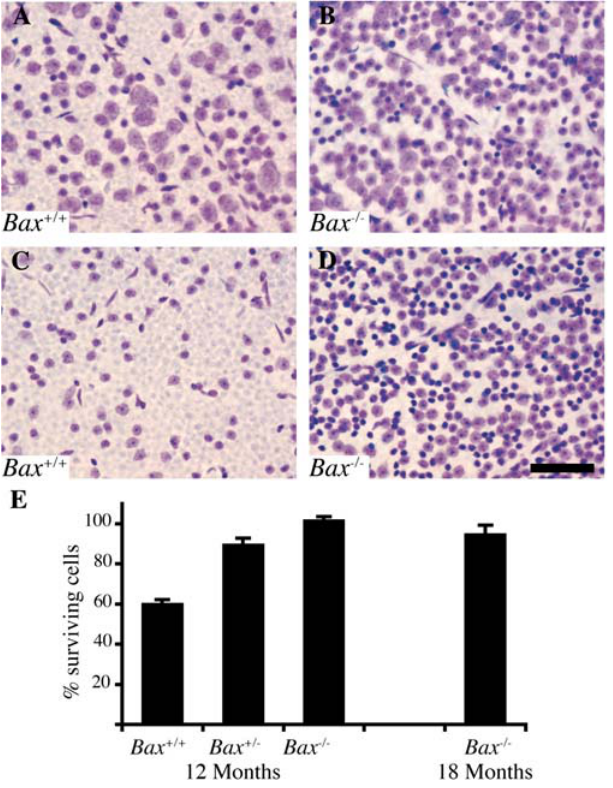
Figure 3. Bax Deficiency Prevents Glaucomatous RGC Death To determine the effects of BAX deficiency on RGC death in glaucoma, we analyzed RGC layer cells at stages with and without glaucomatous optic nerve damage (see Materials and Methods). All shown images are from a similar region of the superior, peripheral retina. (A and B) In both Bax +/+ (A) and Bax (cid:1) / (cid:1) (B) mice without glaucomatous optic nerve damage, the retinas appear healthy. The retinas of